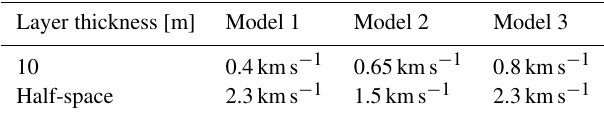
Table 2. Three simplified layered v P velocity models at clayey